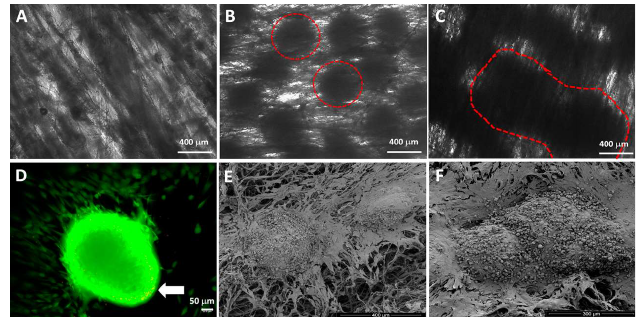
Figure 1. Association of ASC spheroids induced for chondrogenic pathway in PCL nanofibers. ( A ) Aligned PCL nanofibers, ( B ) induced ASC spheroids associated with PCL nanofibers, ( C ) initial stage of induced ASC spheroids fusion, ( D ) induced ASC spheroids associated with PCL nanofibers incubated with cytoplasmic calcein (green staining) and ethidium homodimer (red staining) revealed mostly viable cells and few necrotic cells (arrow). ( E , F ) scanning electron microscopy of induced ASC spheroids associated with PCL nanofibers showing initial stages of spheroids proximity ( E ) and fusion ( F ).